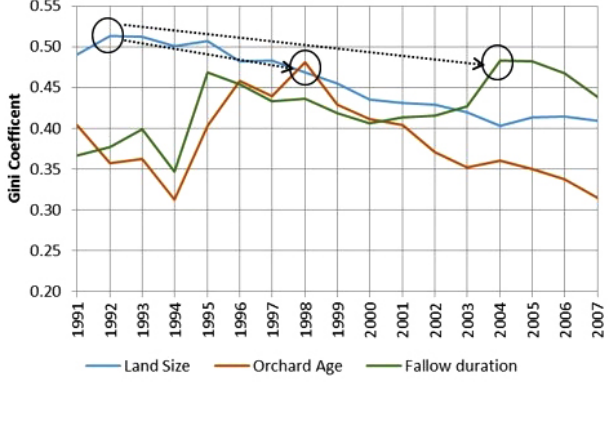
Fig. 4 . Shift from land size to land use inequality on upland, San Jose,